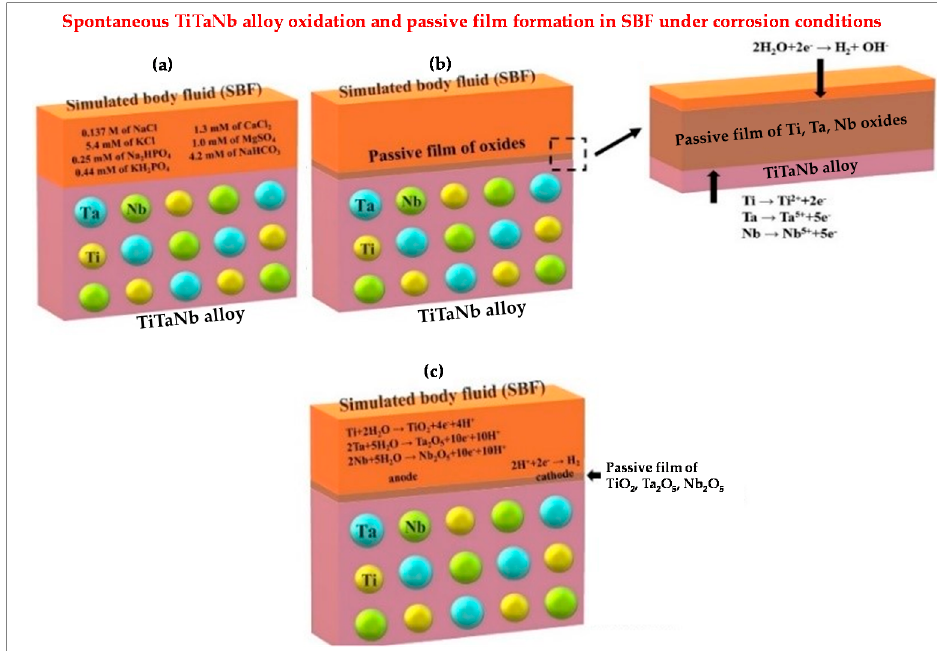
Figure 13. Spontaneous formation of a passive film on β -TiTaNb alloy under corrosion conditions: ( a ) the alloy is in contact with corrosive SBF solution, ( b ) a passive layer grows on the alloy surface under corrosion due to Ti, Ta, Nb metals dissolution and subsequent formation of the correspondent metal oxides, and ( c ) in steady state, passive layer is continuously renewed under corrosion conditions. Adapted from [136], copyright (2020), with permission from Elsevier.